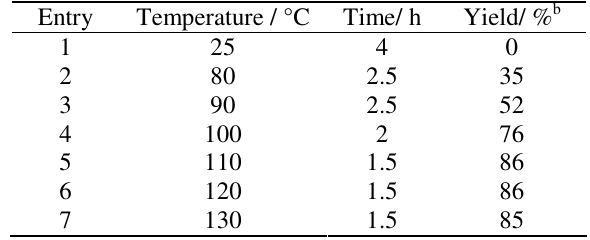
Table 1. Temperature optimization for the synthesis of 3,3 ′ -benzylidene-4,4 ′ -epoxydicoumarin a